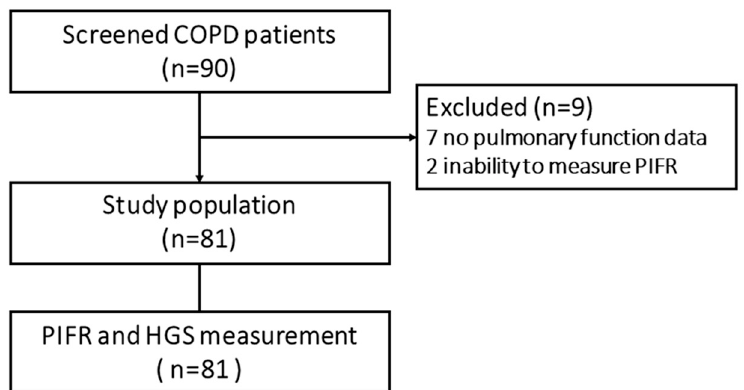
Figure 1. Flowchart of COPD patient recruitment to the